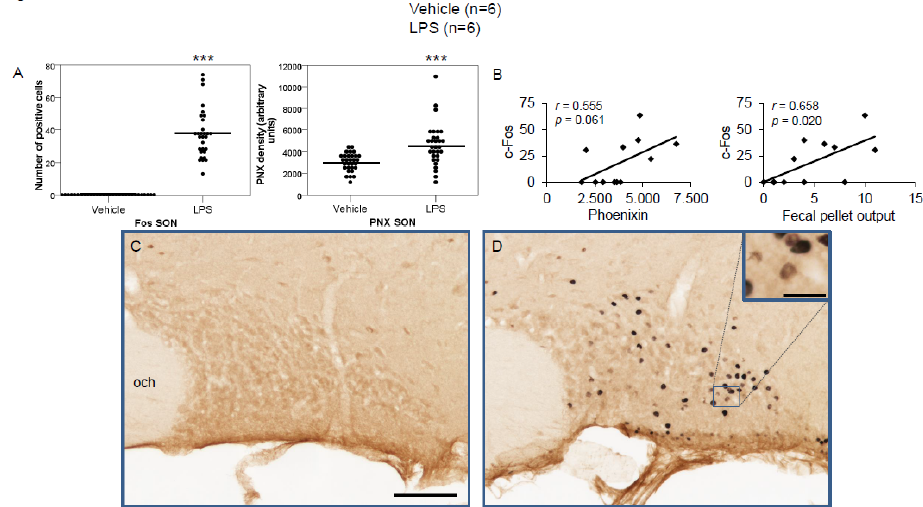
Figure 3. LPS stimulates c-Fos and phoenixin expression in the supraoptic nucleus. Ad libitum-fed rats were subjected to IP injection of LPS or control, and 180 min after the injection, brains were processed for c-Fos and phoenixin double-immunohistochemistry. LPS stress significantly increased the number of c-Fos-positive cells and phoenixin density compared to controls ( A ). No significant correlation was observed between c-Fos and phoenixin immunoreactivity, while the number of c-Fos positively correlated with fecal pellet output ( B ). Representative pictures of the evaluated slides are shown in ( C ) (control) and ( D ) (LPS). The scale bar represents 100 µ m in the overview and 20 µ m in the insert. Data are expressed as individual data points (5/animal) and mean in ( A ). Mean values per animal are plotted in ( B ). *** p < 0.001. Abbreviations: opt, optic tract; SON, supraoptic